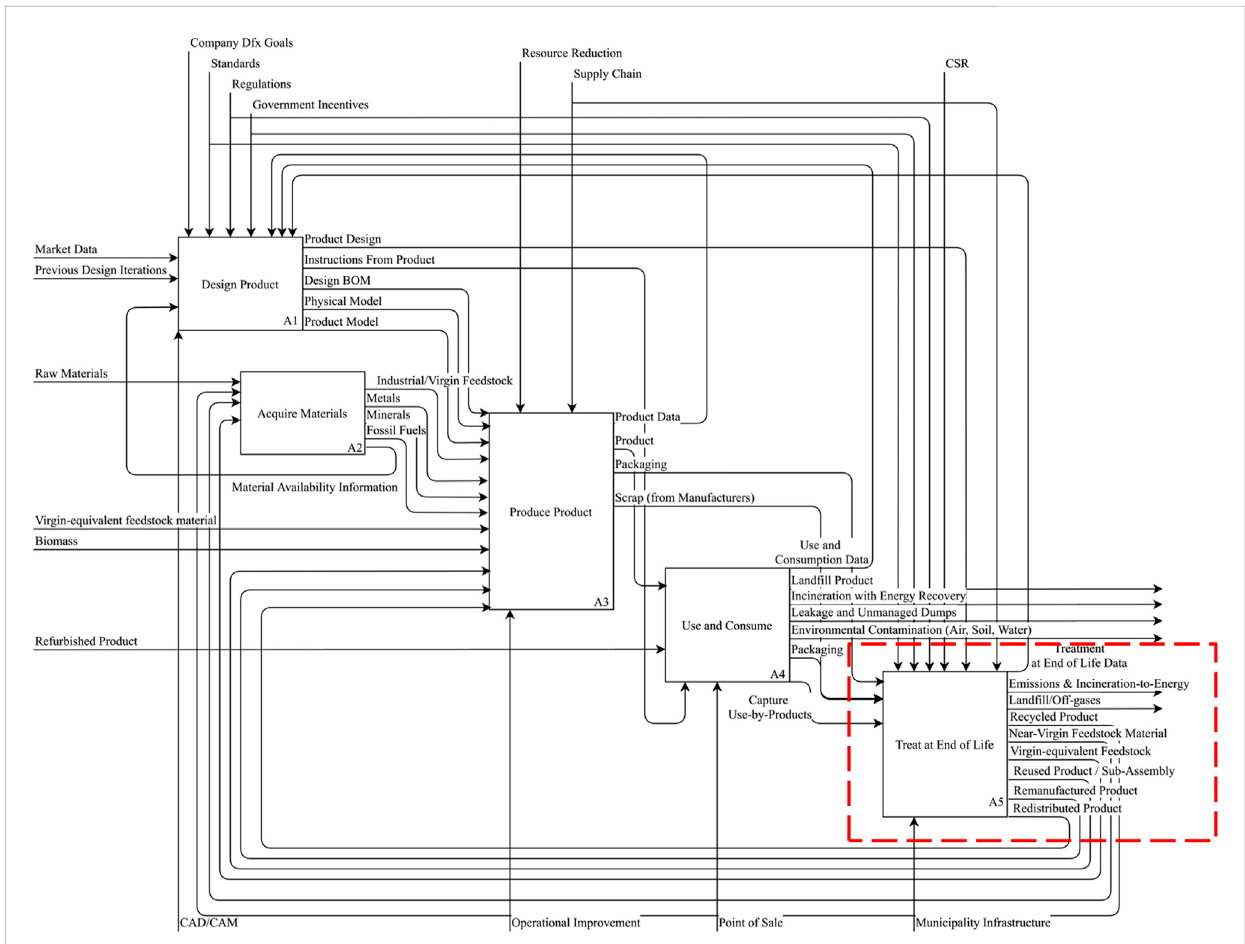
A0manufacturing-basedCEIDEF0functioncomprisingsub-functionsA1,A2,A3,A4&A5(seeFigure1).Thesub-function,A5i.e.,TreatatEndofLife phase is